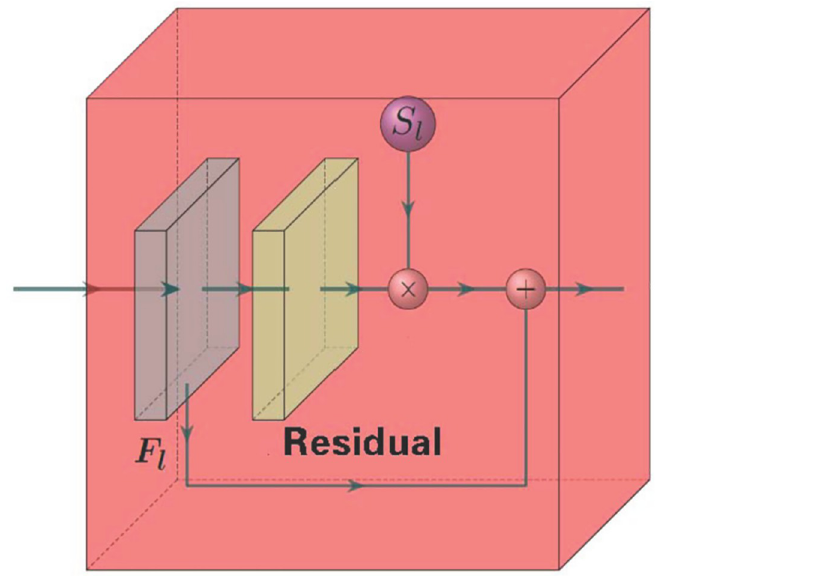
Fig 6. Details of ResBlock